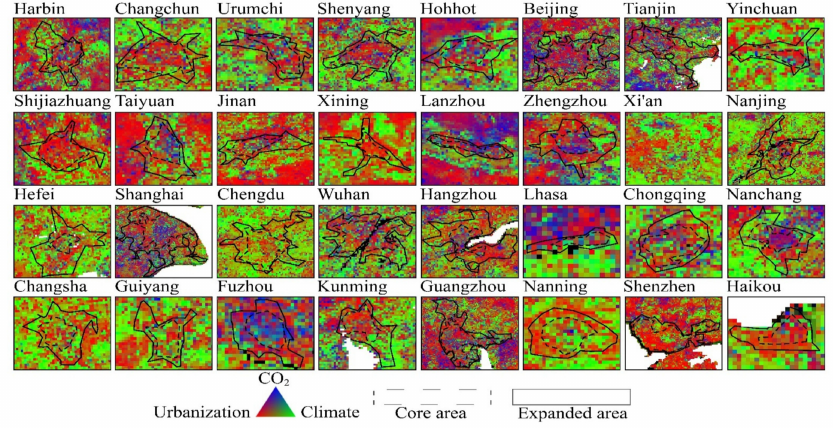
Figure 9. Spatial distribution of driving factor contributions in 32 major urban cities in